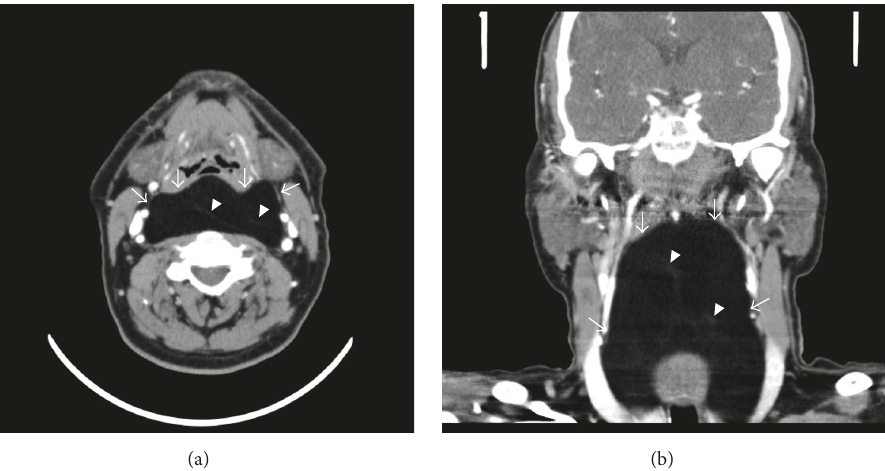
Figure 1: Axial (a) and coronal (b) CT images show a hypodense retropharyngeal mass measuring − 80 HU, compatible with lipoma (arrows). Thin regular septations are also seen (arrowheads).